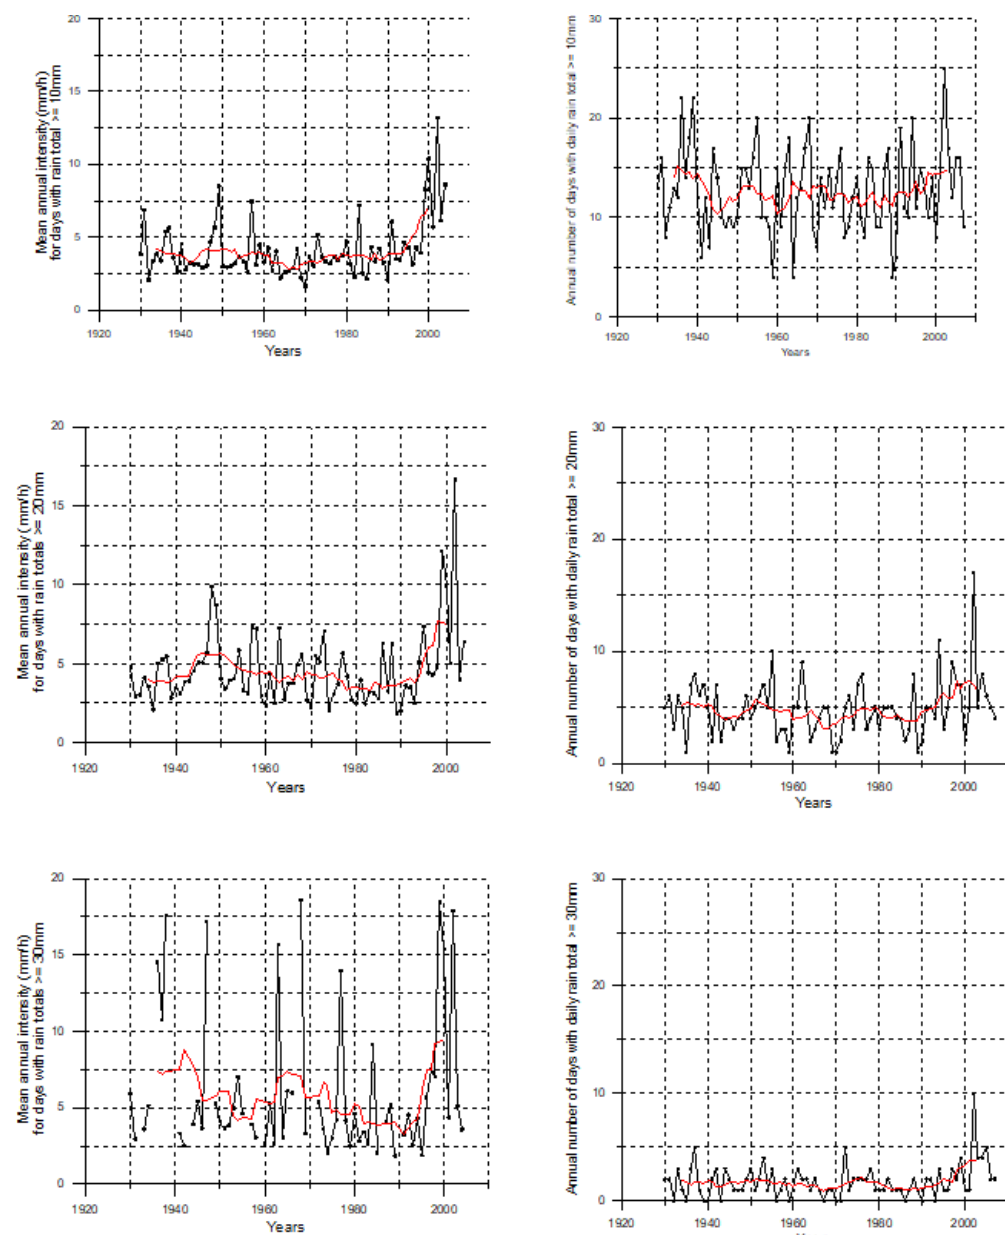
Figure 8. Mean annual rain intensity (mmh − 1 ) (left graphs) and annual number of days (right graphs) with daily rain totals ≥ 10, 20 and 30mm, along with the 9 points moving average fitting (red line), for Athens during the period 1930–2004 (adapted from Nastos et al., 2017).